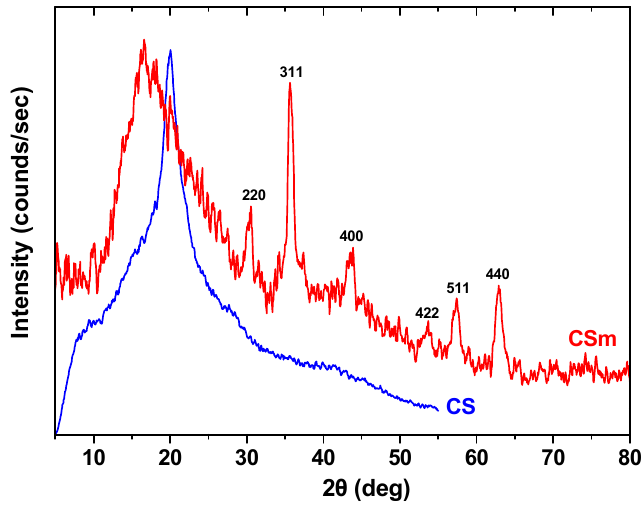
Figure 2. X–ray diffraction (XRD) patterns of CS and CSm.